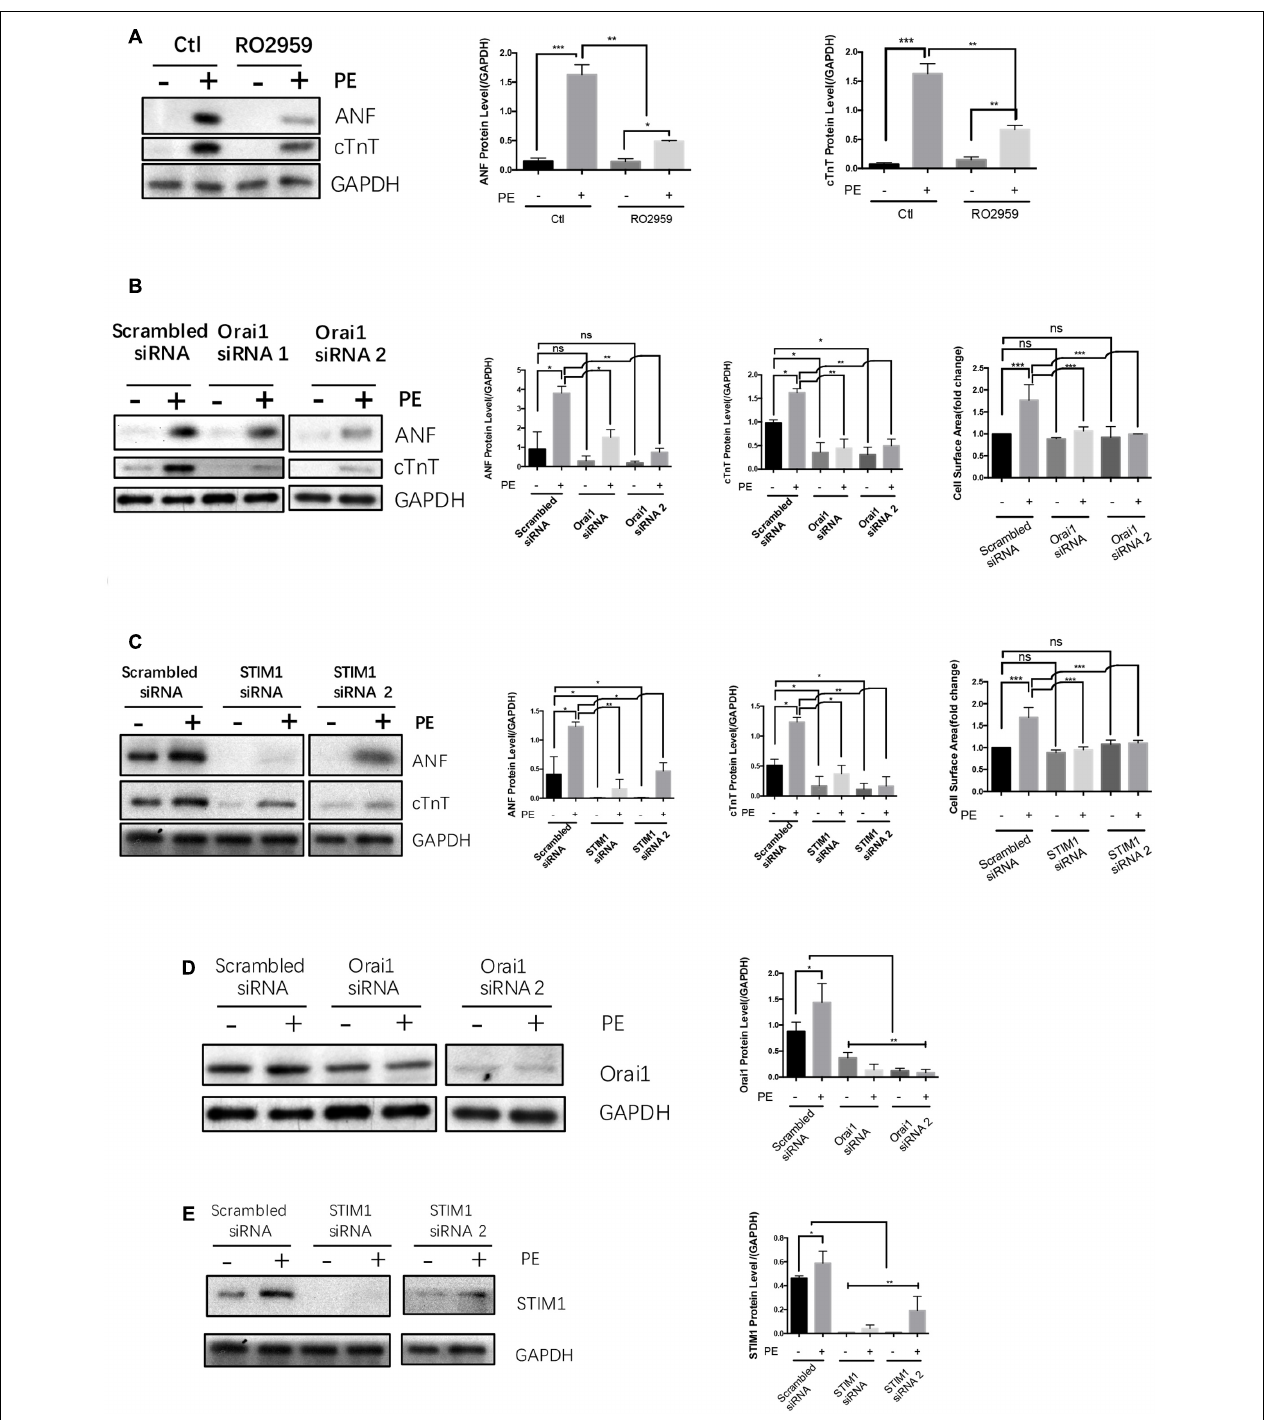
FIGURE 4 | SOCE/STIM1/Orai1 were linked to hypertrophy in NRCMs. NRCMs were treated with 5 µ mol/L RO2959, or transfected with Orai1-siRNA, STIM1-siRNA or Scrambled-siRNA, followed by 50 µ mol/L PE for 48 h to induce hypertrophy. Negative control group (–) did not undergo PE treatment. (A) Effects of RO2959 on PE-induced cardiomyocyte hypertrophy. (B,C) Effects of Orai1-siRNAs and STIM1-siRNAs on PE-induced cardiomyocyte hypertrophy. The hypertrophy was assessed by protein expression of ANF and cTnT (A–C) as well as cell surface area (B,C) . (D,E) Effectiveness of Orai1-siRNAs and STIM1-siRNAs in suppressing the protein expression of their respective targets. Shown were representative Western blot images (left) and data summary (right). The data are expressed as the mean ± SEM ( n = 5). ∗ p < 0.05; ∗∗ p < 0.01; ∗∗∗ p < 0.001. ns, not significant.